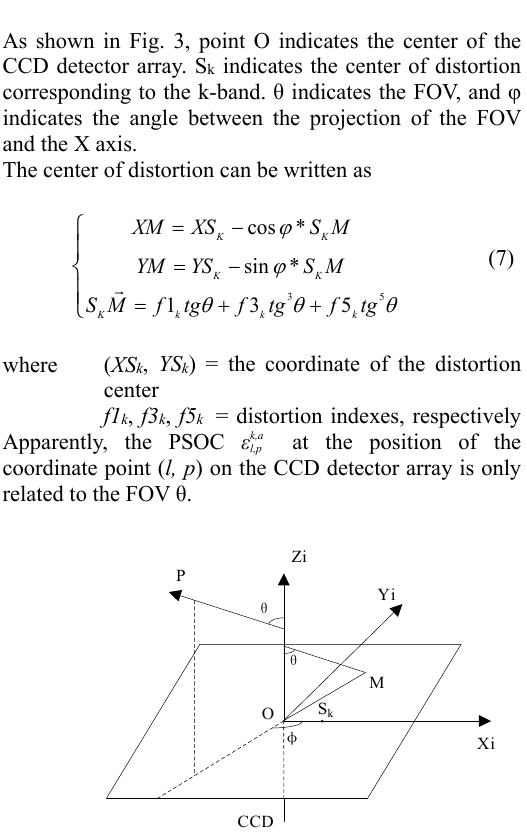
Figure 3. Wide FOV geometric calibration model